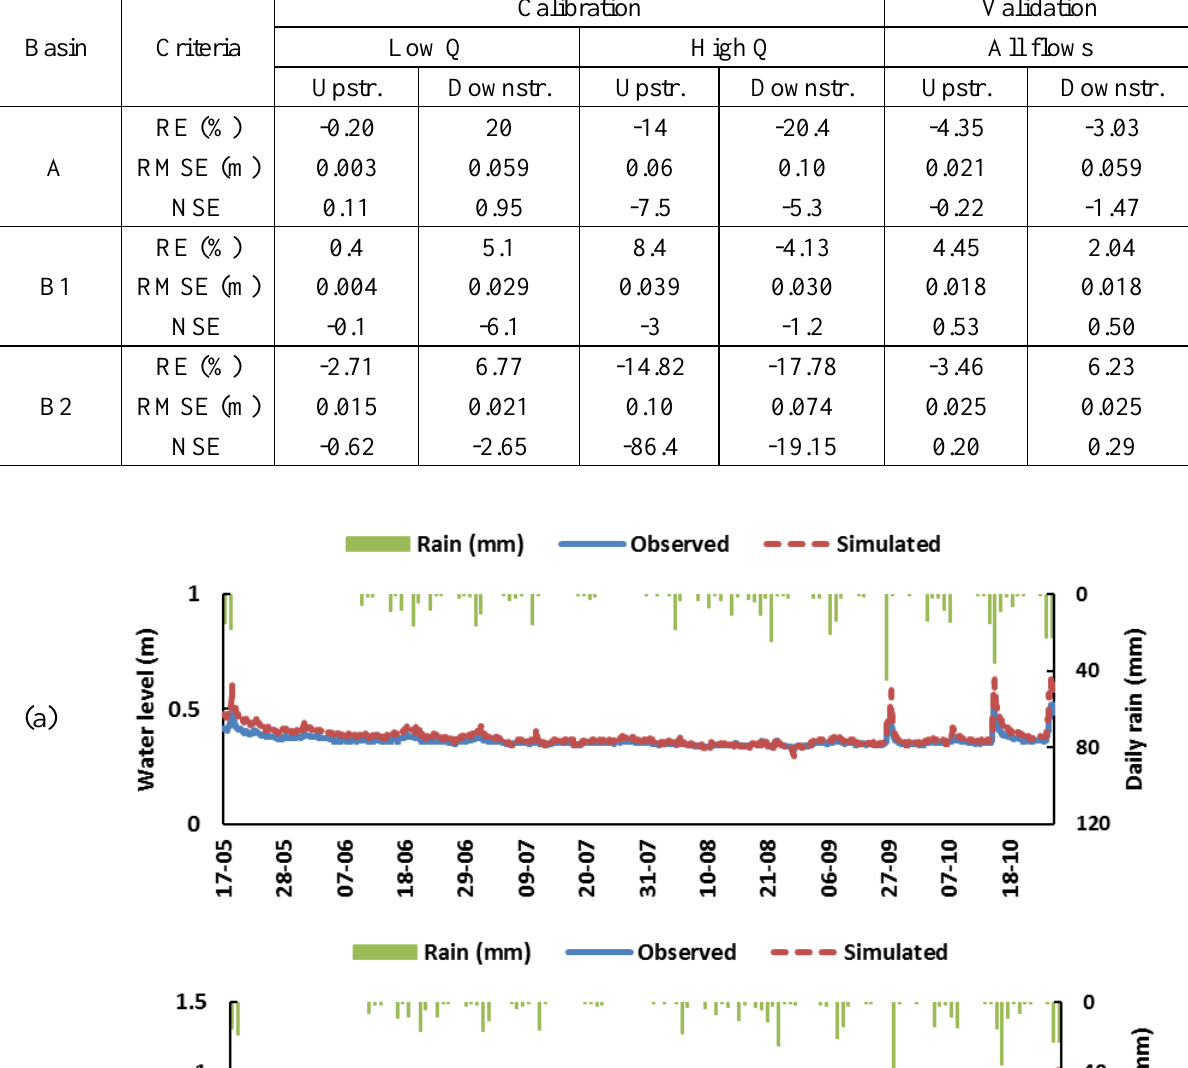
Table 4. Calibration and validation results of the hydraulic model for Basin A and Basins B1–B2 (in series).